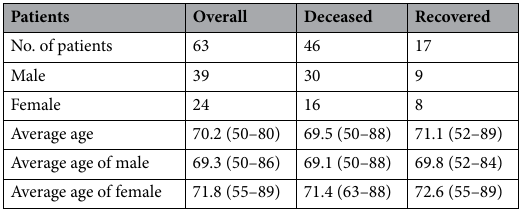
Table 1. Details of COVID-19 patients’ age and